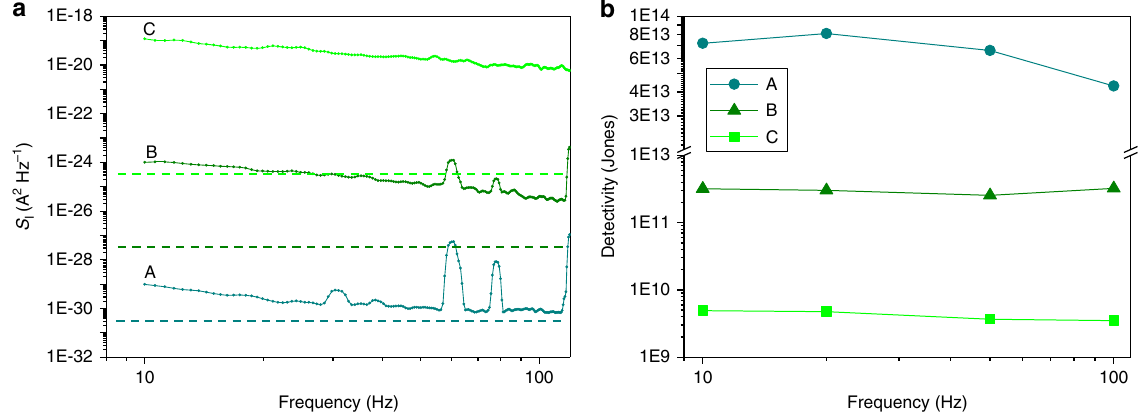
Fig. 6 Noise power spectral density and speci fi c detectivity. a S I as function of modulation frequency in 1GQ-OQO phototransistor. A, B, and C denote three different measurement regimes, corresponding to V G values of − 18, − 15, and 12 V, respectively, (see also, Supplementary Fig. 13a). b Estimation of D * for three regimes of operation vs.